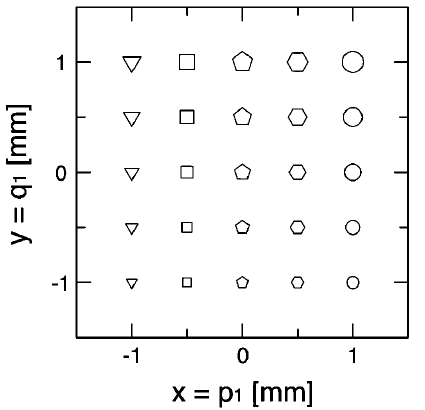
FIG. 9. Location of 25 test charges.